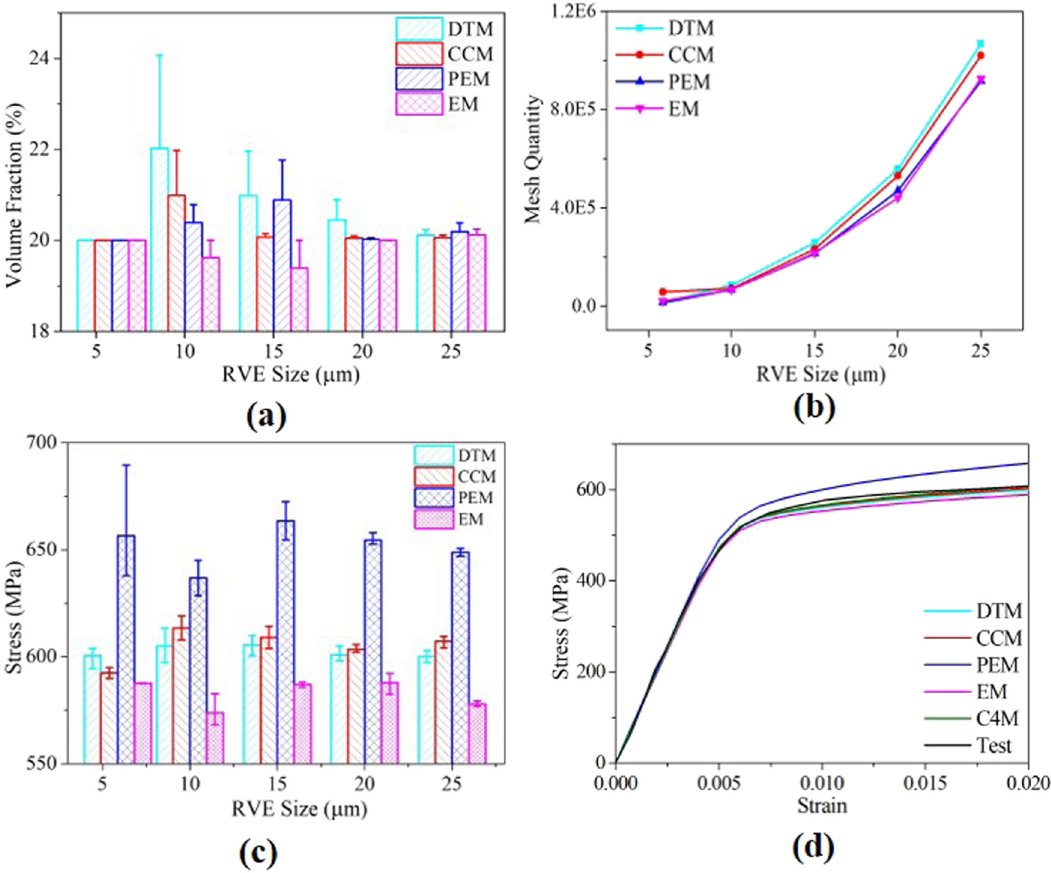
Figure 6: ( a ) Histograms of di ff erent RVE sizes and volume fractions, ( b ) mesh quantity, ( c ) stress at a strain of 2%, and ( d ) tensile stress – strain